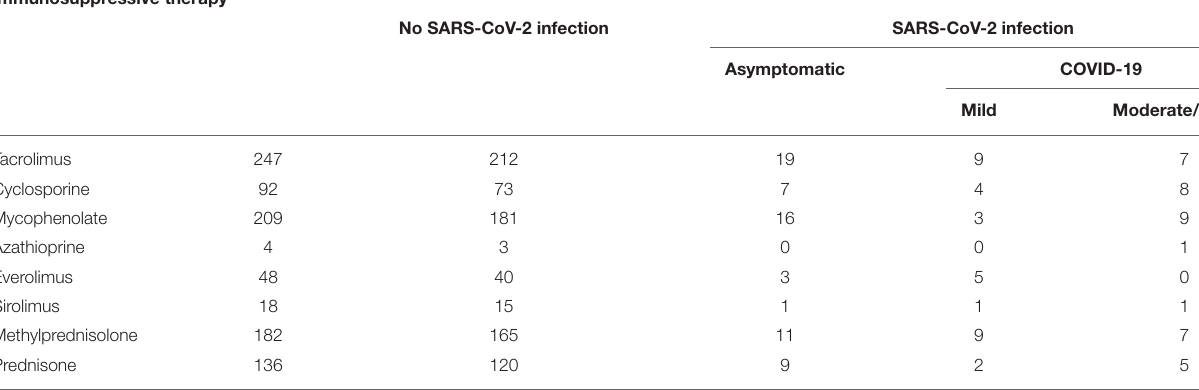
TABLE 5 | Immunosuppressive therapy evaluation for single immunosuppressant. Immunosuppressive